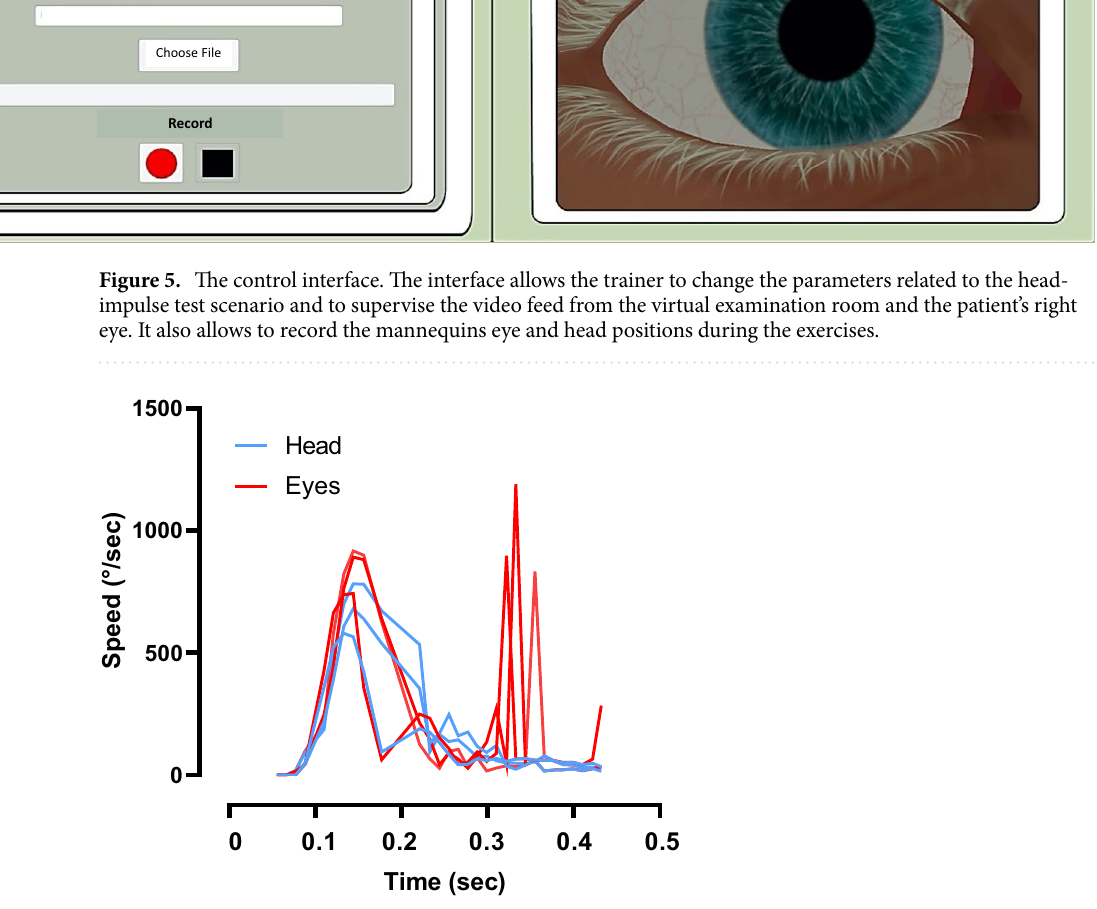
Figure 6. Recording of 3 virtual head impulse tests by the system. Eye and head positions were sampled at 120 Hz. In this example, the saccade (arrow) delay was set at 110